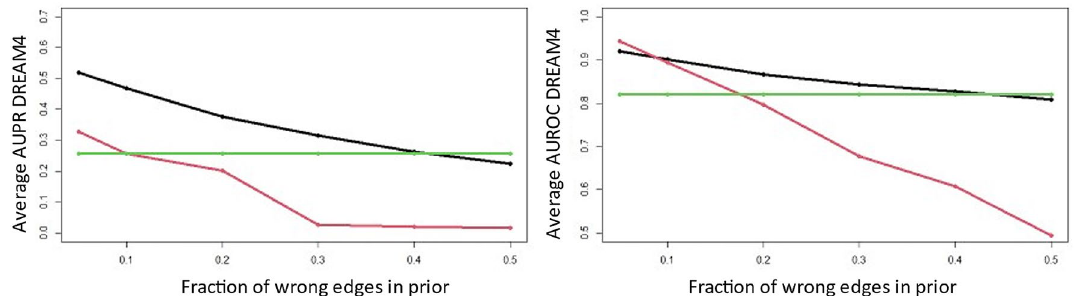
Figure 4. Effect of an Informative Prior into KBoost on the DREAM 4 Multifactorial Dataset The red line represents the average of the prior networks, the green line the average results with a non-informative prior and the black line the average of the posterior networks with an informative prior. The results highlight the advantage of having prior information even if it is limited to a few TF—target gene pairs. It also shows that when the prior information is not accurate it can have a detrimental effect on performance.